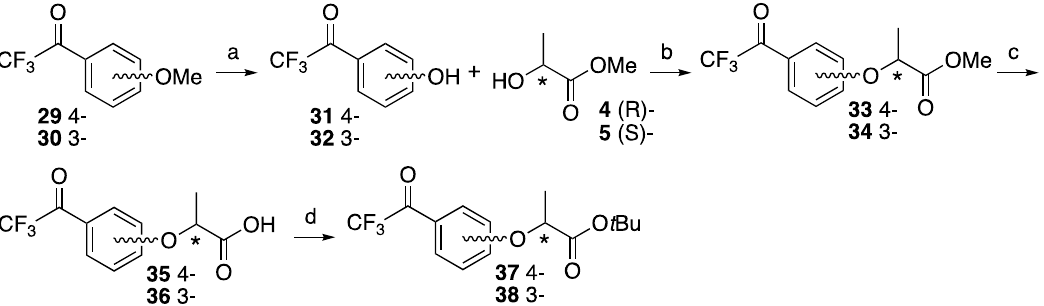
Figure 5. Synthesis of 3- and 4-trifluoroacetyl lactisole derivatives. ( a ) LiCl, DMF, reflux, 5 h for 31 82%, BBr 3 , CH 2 Cl 2 , rt, 2 h for 32 quant. ( b ) (1) PPh 3 , CH 2 Cl 2 , 0 °C, 10 min; (2) DEAD, CH 2 Cl 2 , rt, 8 h, ( S )- 33 78%, ( R )- 33 74%, ( S )- 34 71%, ( R )- 34 75%. ( c ) K 2 CO 3 , MeOH, H 2 O, reflux, 2 h, ( S )- 35 quant., ( R )- 35 95%, ( S )- 36 99%, ( R )- 36 97%. ( d ) t -BuBr, K 2 CO 3 , tetrabutylammonium bromide (TBAB), DMA, 55 °C, 5 h, ( S )- 37 66%, ( R )- 37 70%, ( S )- 38 38%, ( R )- 38 37%.